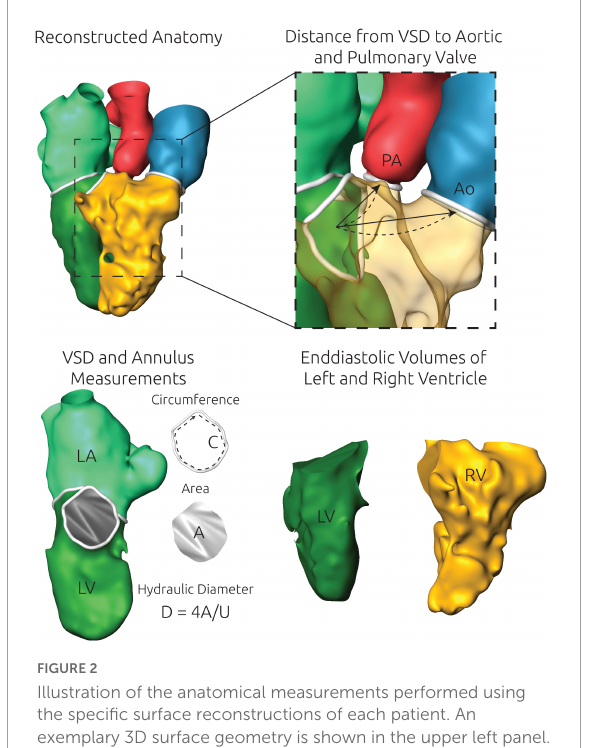
FIGURE2 Illustration of the anatomical measurements performed using the specific surface reconstructions of each patient. An exemplary 3D surface geometry is shown in the upper left panel. Top right) The distance from the center of mass of the ventricular septal defect (VSD) and the aortic and pulmonary valve annulus were measured automatically by two approaches. First, the shortest linear connection (arrow) was calculated. Second, a cubic spline (dashed line) was generated to calculate a more realistic curved path. Bottom left) For each valve annulus as well as the VSD, which is shown here exemplarily, the circumference C and the cross-sectional area A were measured. From those two measurements the hydraulic diameter D was calculated. Bottom right) The left (LV) and the right ventricle (RV) were separated from each other and the exact volume of the closed surface geometries of both structures was